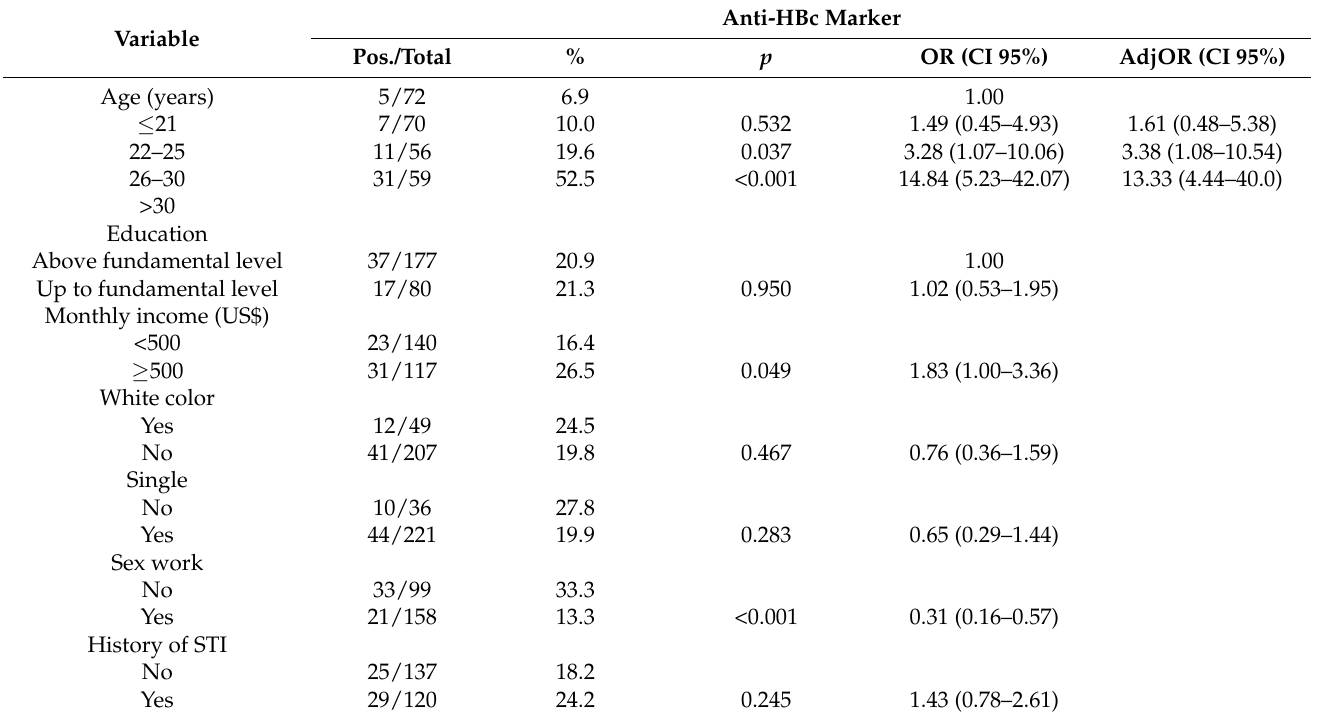
Table 3. Multivariate analysis of factors associated with HBV exposure (anti-HBc) among transgender women in Central